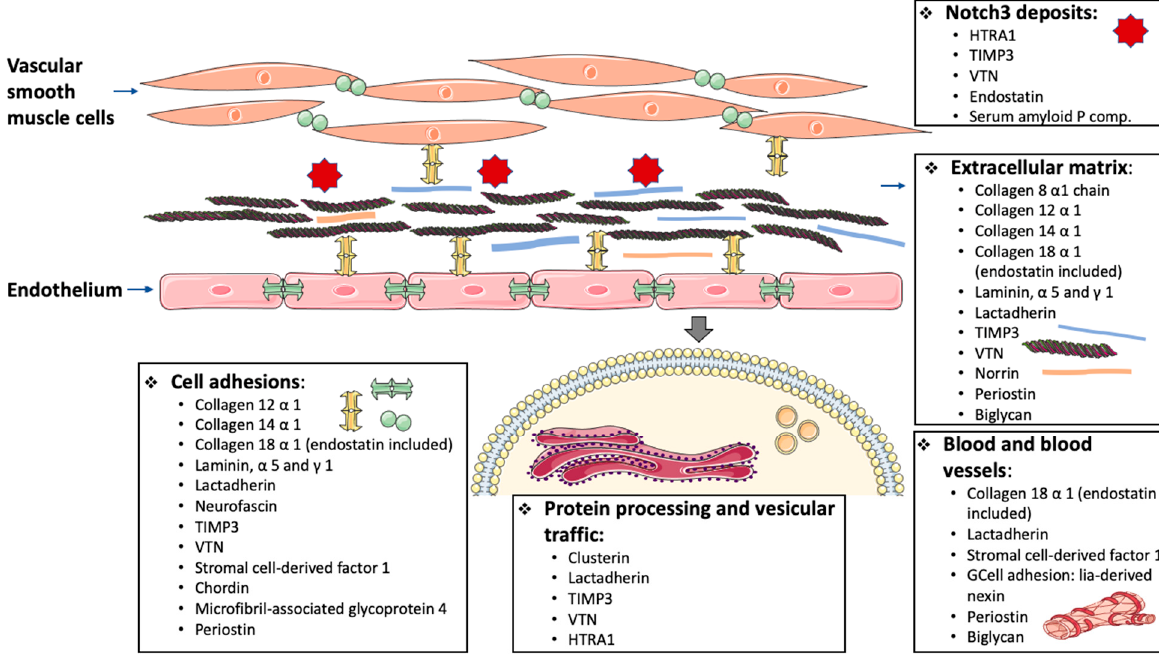
Figure 4. Schematic diagram of those molecules found in the -omics studies regarding its possible aetiopathogenic mechanism. Molecules found in at least two studies and with the same direction of effect have been considered. Graphic created through the smart.servier.com website.